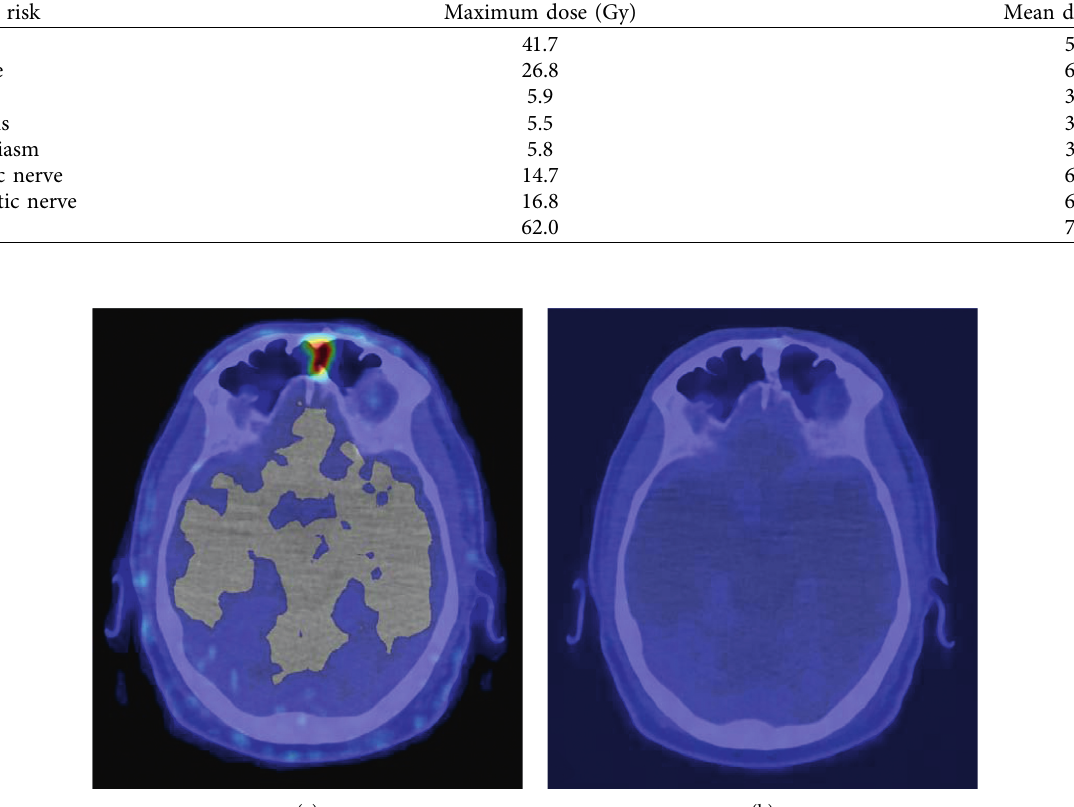
Table 1: Dose received by organs at risk.